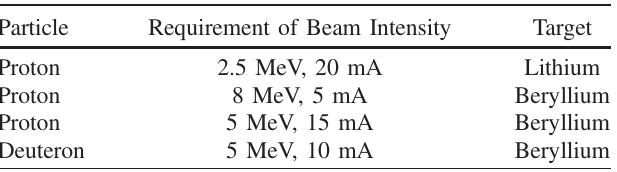
TABLE I. The required beam intensity for producing adequate number of neutrons for boron neutron capture therapy. The aim value of the neutron yield is determined by the accelerated particle, beam energy, beam current, and a target material (Be or Li). The National Cancer Center in Japan adopts the BNCT system with a beam intensity of (2.5 MeV, 20 mA) and lithium target [1]. The i-BNCT project proceeding at Ibaraki, Japan, aims to develop a BNCT system with a beam intensity of (8 MeV, 5 mA) and Beryllium target